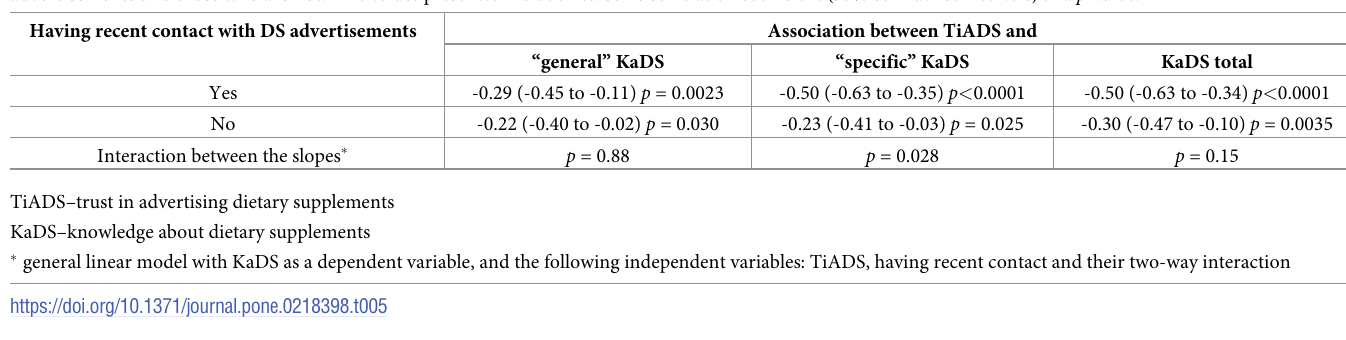
Table 5. The association between the knowledge about dietary supplements and trust in advertising them among the general public: Those in recent contact with advertisements and those who are not. The values presented include Pearson’s correlation coefficient (95% confidence intervals) and p -value. Having recent contact with DS advertisements